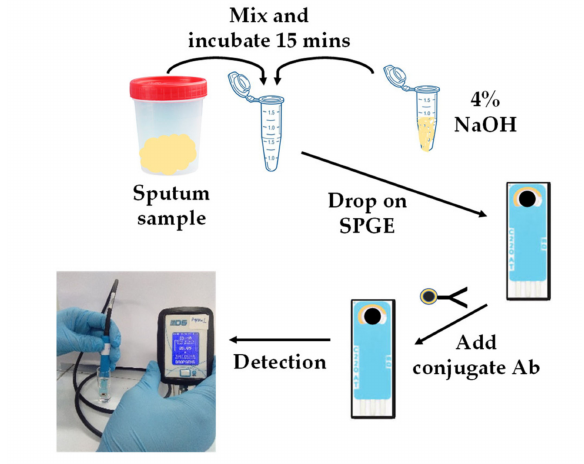
Figure 1. Sputum sample analysis for CFP10-ESAT6 antigen using portable readers. (i) The sample was decontaminated in 4% NaOH for 15 min and dropped onto the surface of modified electrode, (ii) Fe 3 O 4 /Au-Ab was dropped after the treated sample incubated on the capture aptamer (CapApt)/ graphene (GP)/polyaniline (PANI)/ screen-printed gold electrode (SPGE) surface for 40 min, and (iii) the prepared electrode was ready for measurements using portable